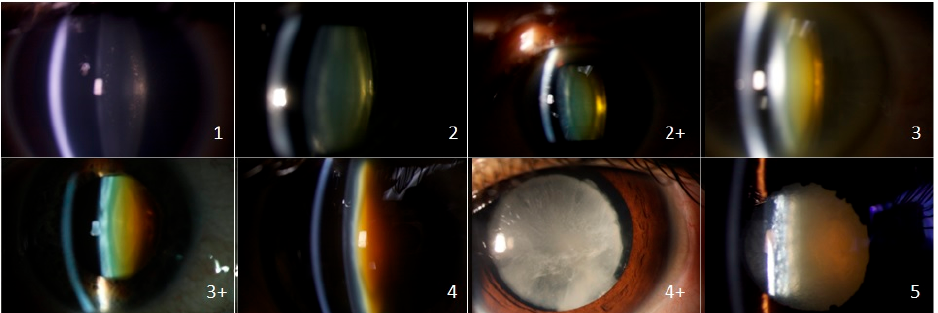
Figure 1. Standard Pre-Operative Nuclear Classification System (SPONCS) Canon EOS slit-lamp photographic examples.